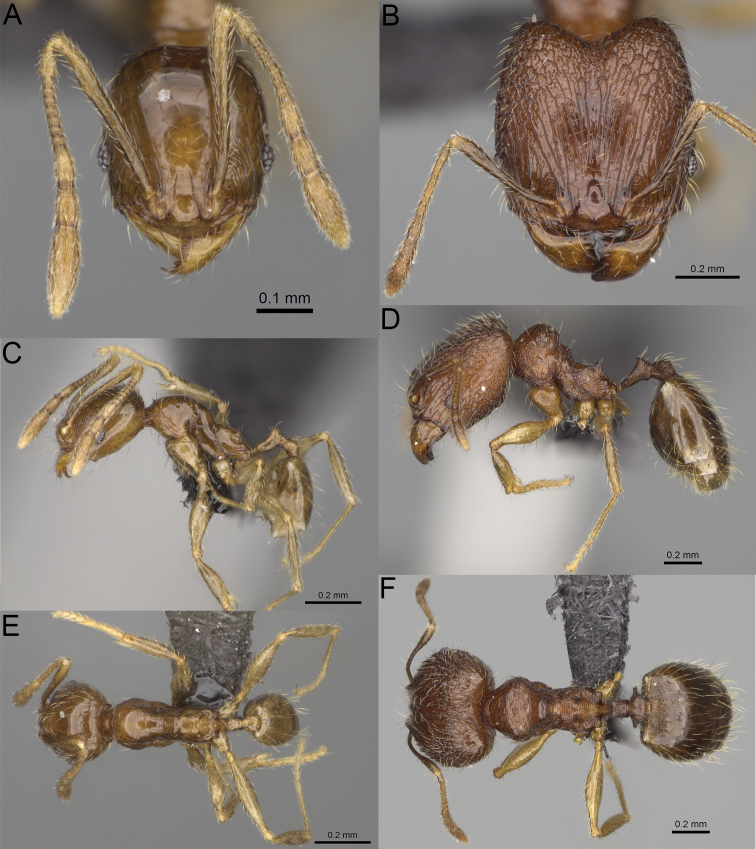
Pheidole
nitidobruna sp. nov., full-face view (A), profile (C), and dorsal view (E) of paratype minor worker (CASENT0245024) and full-face view (B), profile (D), and dorsal view (F) of holotype major worker (CASENT0923273).